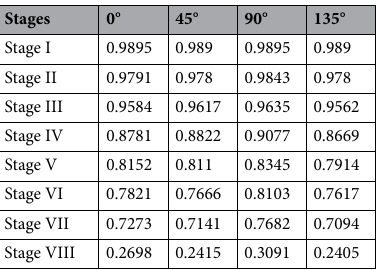
Table 3. Variation of IDM of surface discharge images during AC flashover process.